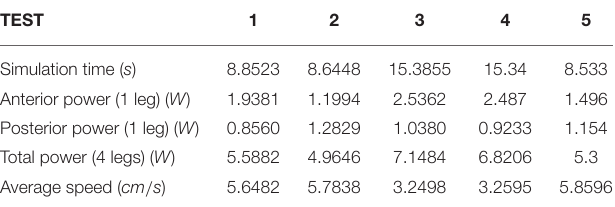
TABLE 3 | Results of the five tests.